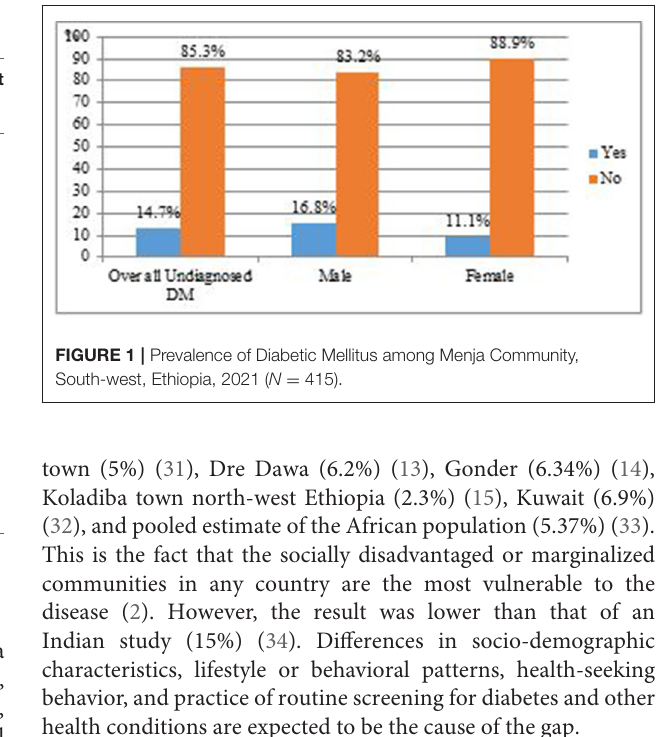
TABLE 3 | Clinical and anthropometric measurements of the participants, Menja community, South-west, Ethiopia, 2021 ( N = 415).